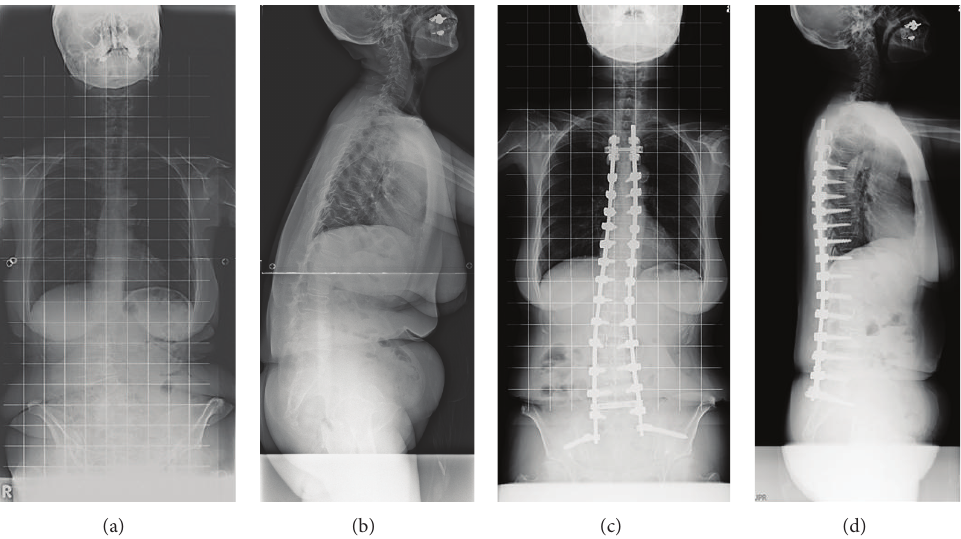
Figure 3: X-ray film images from a 70-year-old woman before and after surgery (Case 2). Anterior-posterior view (a) and lateral view (b) before surgery and anterior-posterior view (c) and lateral view (d) after